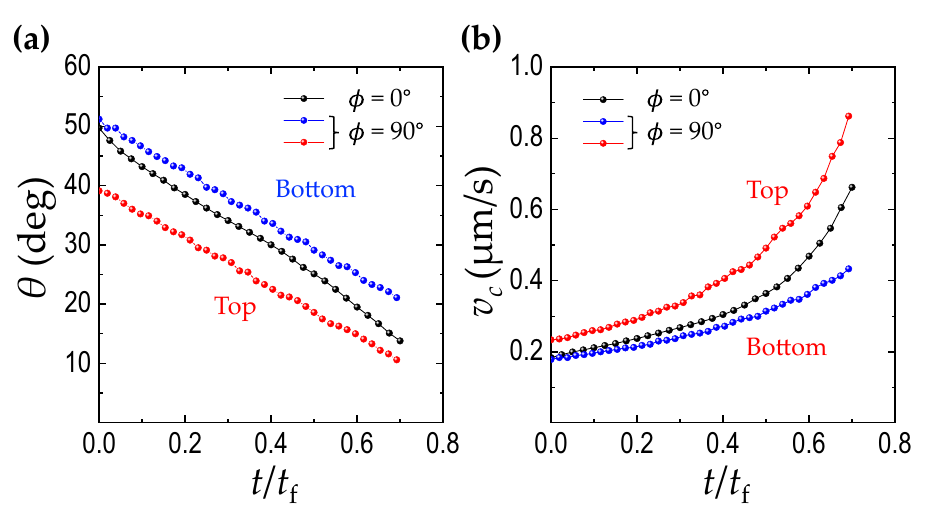
Figure 5. Contact angle influence on capillary flow velocity. ( a ) The temporal evolution of the measured contact angle for φ = 0 ◦ and 90 ◦ . ( b ) Theoretically obtained capillary flow velocity for φ = 0 ◦ and 90 ◦ . The black circles come from the non-inclined droplet, and red and blue circles are from the top and bottom contact point of the 90 ◦ inclined droplet, respectively. This result suggests that the contact angle is crucial to determine the evaporation rate, leading to a wider deposit ring on the top section due to a dominant capillary